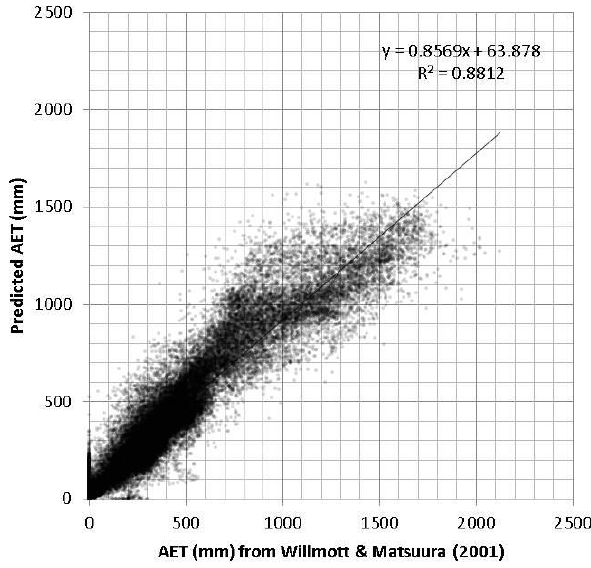
Fig. A1. Comparison between our model-derived estimates of an- nual actual evapotranspiration (AET) and those predicted by the model of Matssura and Willmott (2009). Predicted AET (mm) was calculated using the methodology described in Sect. 3.2.6 for land grid squares at 0.5 degree resolution. Points are partially transparent to help emphasise differences in data density.